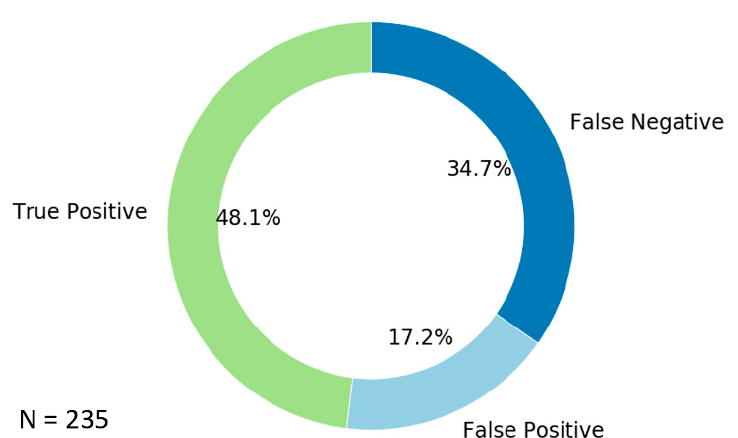
Figure 5. Percentage of matchup profiles between January and March 2018 for the true positive, false positive, and false negative CAA detection states that are summarized in Table 1. Profiles categorized as true negative are the most numerous (N = 1026) but for clarity, are not shown.